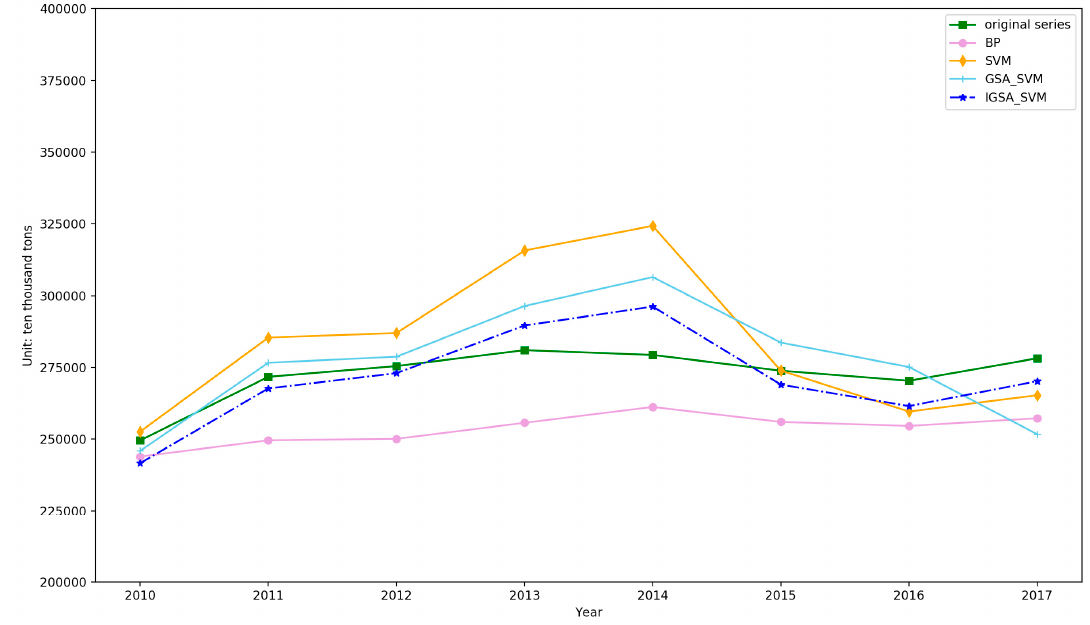
Figure 5. Forecasting results comparison.